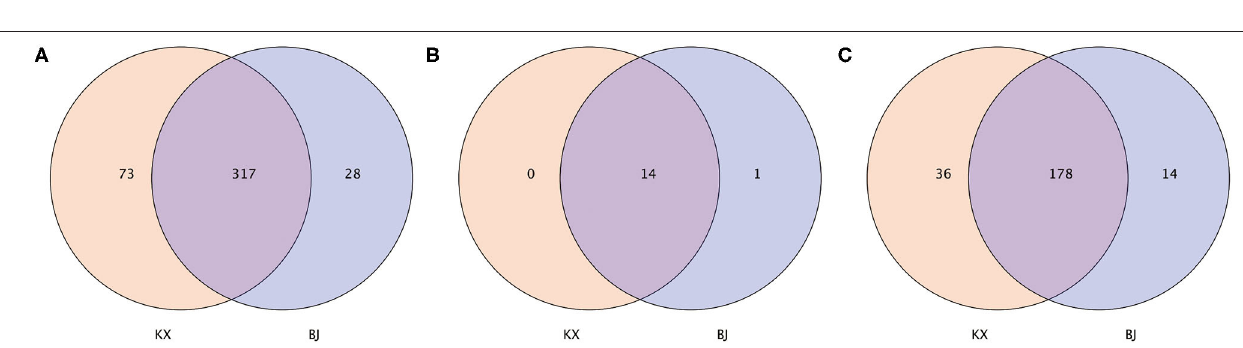
FIGURE 2 | Venn diagram of the bacterial community in the analyzed groups. It shows the numbers of shared or not shared operational taxonomic units (OTUs; 97% sequence identity) (A) , phyla (B) , and genera (C) by Mu Us Desert (KX) and Bojiang Haizi (BJ) individuals depending of